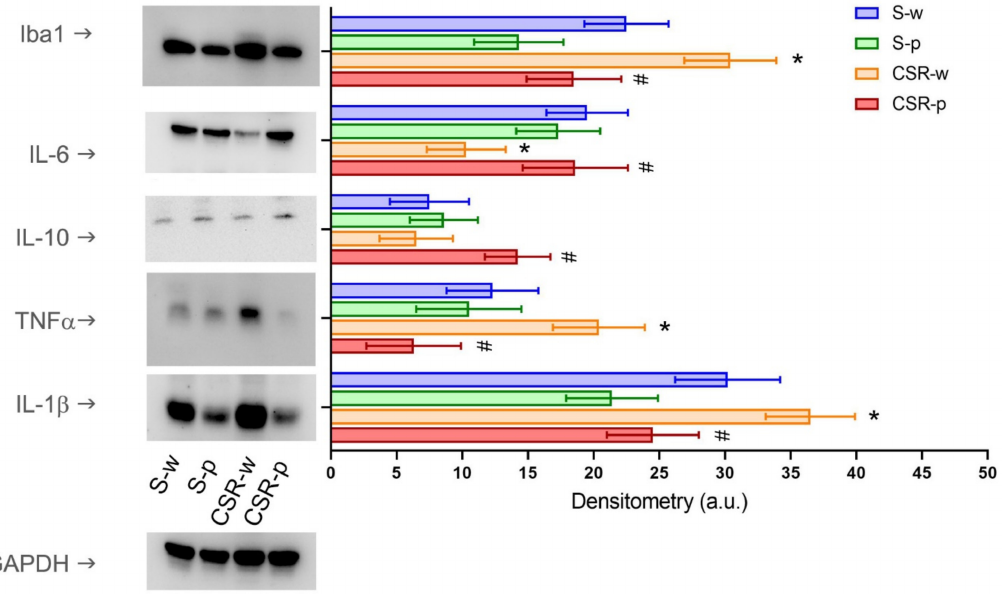
Figure 4. Effects of CSR and SLAB51 on neuroinflammation. Neuroinflammation cytokines levels measured in brain homogenates of all groups. The densitometric analyses obtained from three separate blots and representative immunoblots are shown. Equal protein loading was verified by using an anti-GAPDH antibody. Values are mean ± SEM. One-way ANOVA results were (F (3, 24) = 6.239; p = 0.00276) for Iba1, (F (3, 24) = 3.379; p = 0.03473) for IL-6, (F (3, 24) = 3.847; p = 0.02220) for IL-10, (F (3, 24) = 7.774; p = 0.00085) for TNF α , and (F (3, 24) = 4.534; p = 0.01179) for IL-1 β . * indicates statistical significance between S-w and CSR-w, while # indicates statistical significance between CSR-w and